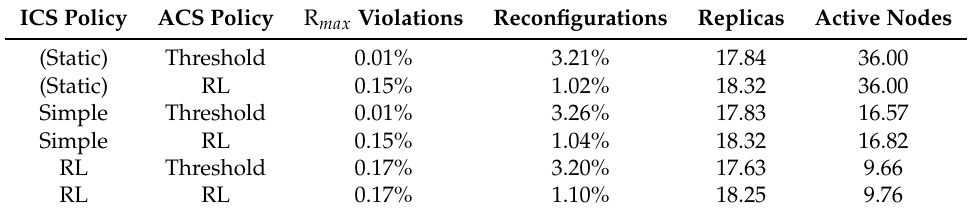
Table 1. Results with different combinations of policies for the ICS and the ACS. We report the percentage of time in which the target response time R max is violated, the percentage of time in which the ACS decides to reconfigure the application, the average number of operator replicas, and the average number of used computing nodes.